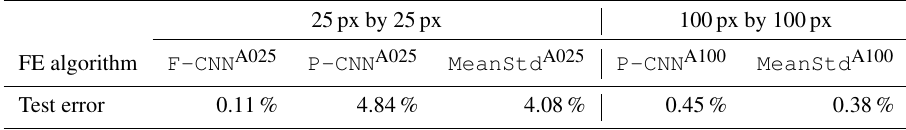
Table 4. The test errors of the different methods with different patch sizes. For patch size 25 pixels by 25 pixels the method with the fine-tuned CNN FE algorithm F-CNN A025 has the smallest error. For patch size 100 pixels by 100 pixels the mean–standard deviation FE algorithm MeanStd A100 performs better than the pretrained CNN FE algorithm P-CNN A100 . The case studies and sensitivity analyses results, shown elsewhere, demonstrate that F-CNN A025 identifies optically thick aerosols and cirrus clouds at higher accuracies compared to the other methods. The discrepancy between the test errors and what is observed in case studies and sensitivity results indicates that test error is not necessarily an accurate predictor of the out-of-sample (i.e., samples that are not in the training and test datasets) misclassification error.